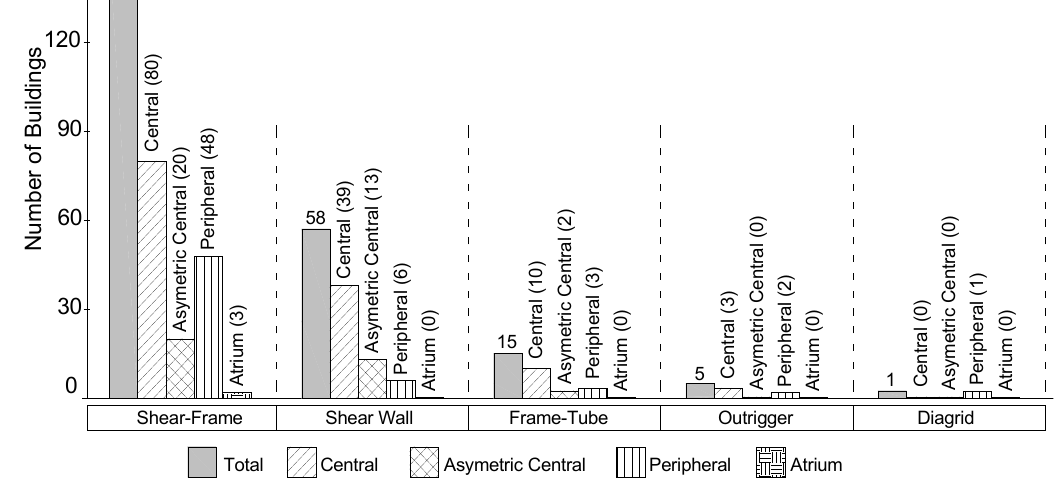
Figure 17 illustrates the tall building structural system and the number of core types used in these systems. The grey bars on the left axis of the graph demonstrate the total number of tall buildings. In the shear-frame system, the central core is the most common design, with a rate of 53%. The central core is followed by the peripheral core at 31.8%, the asymmetric central core at 13.2% and the atrium core at 2.0%. The central core is the most common design in the shear wall system, with a rate of 67.2%. The central core is followed by an asymmetric central core at 22.4% and the peripheral core at 10.4%. In the frame-tube system, 60.0% of the tall buildings are designed with the central core, 26.7% with the peripheral core and 13.3% with the asymmetric central core, while the atrium core is not designed. In the outrigger system, 60.0% are designed with the central core and 40.0% with the peripheral core, while asymmetric central core and atrium core are not designed in this system. The peripheral core is designed in one completed tall building with the diagrid system in the analyzed sample tall building group.